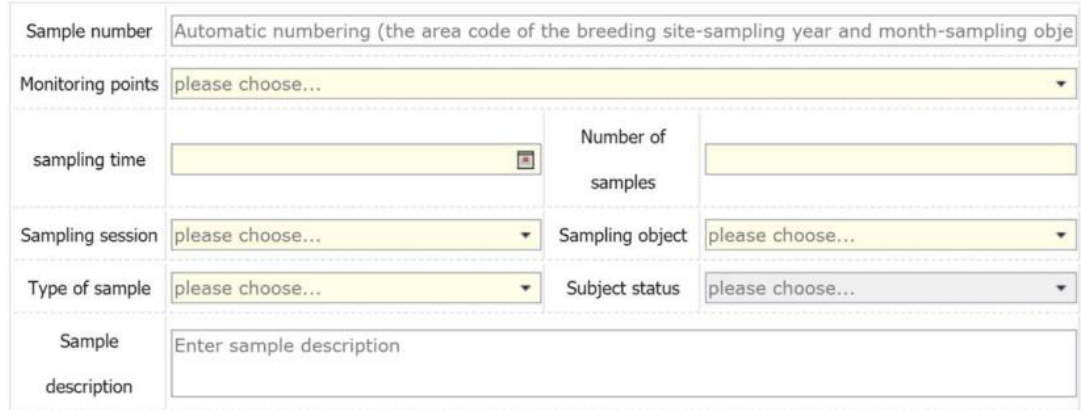
Figure 3. The framework of the system.